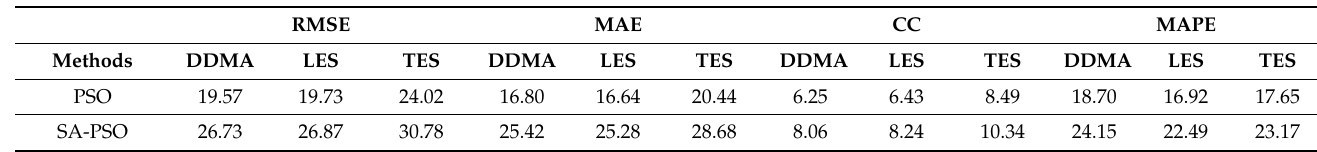
Table 2. The improvement rates (Unit:%) of the average RMSE, MAE, CC, and MAPE estimated PSO and SA-PSO methods for the swell height of eight CYGNSS satellites compared with DDMA, LES, and TES observables.